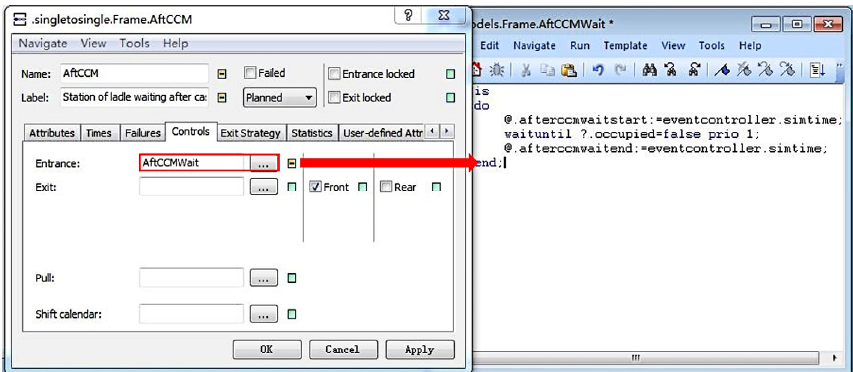
Figure 4. Record on the waiting times of heats after casting.